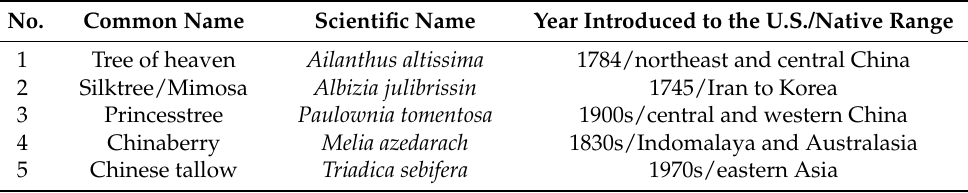
Table 1. Target invasive tree species on Mississippi forestlands from year 2009 to